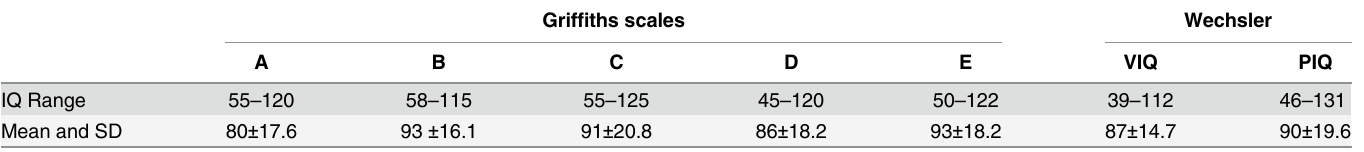
Table 1. Mean and SD of specific Neurodevelopmental and Wechsler Subquotients.